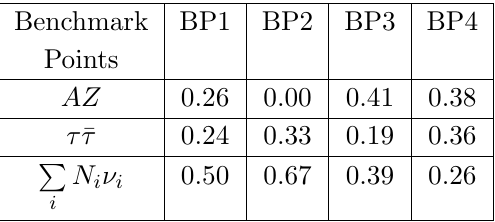
Table 4 . Branching fraction for H for the benchmark points for collider study at the LHC.